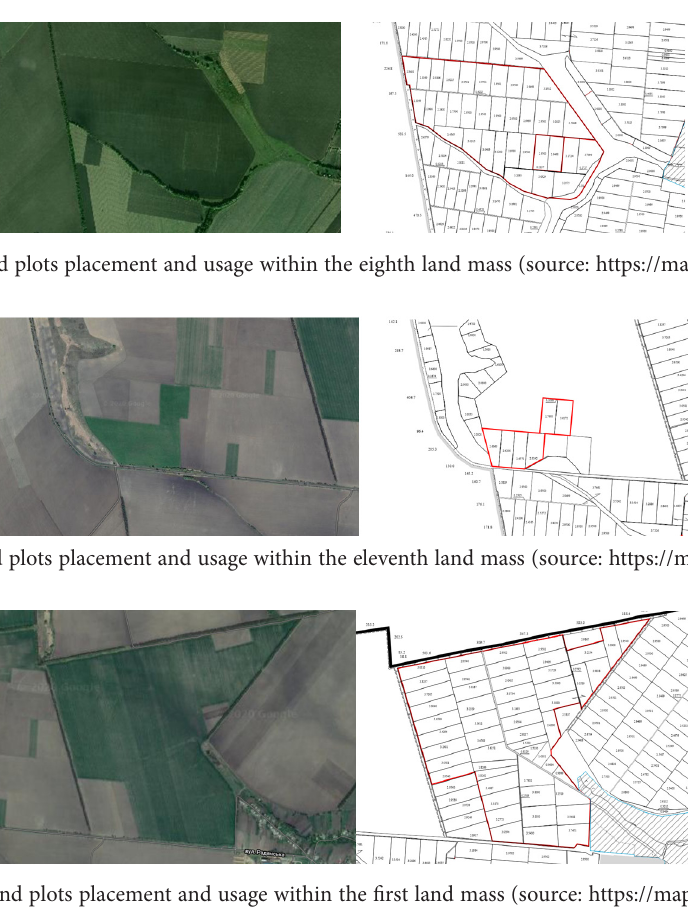
Figure 2. Land plots placement and usage within the fourth land mass (source: https://map.land.gov.ua/)